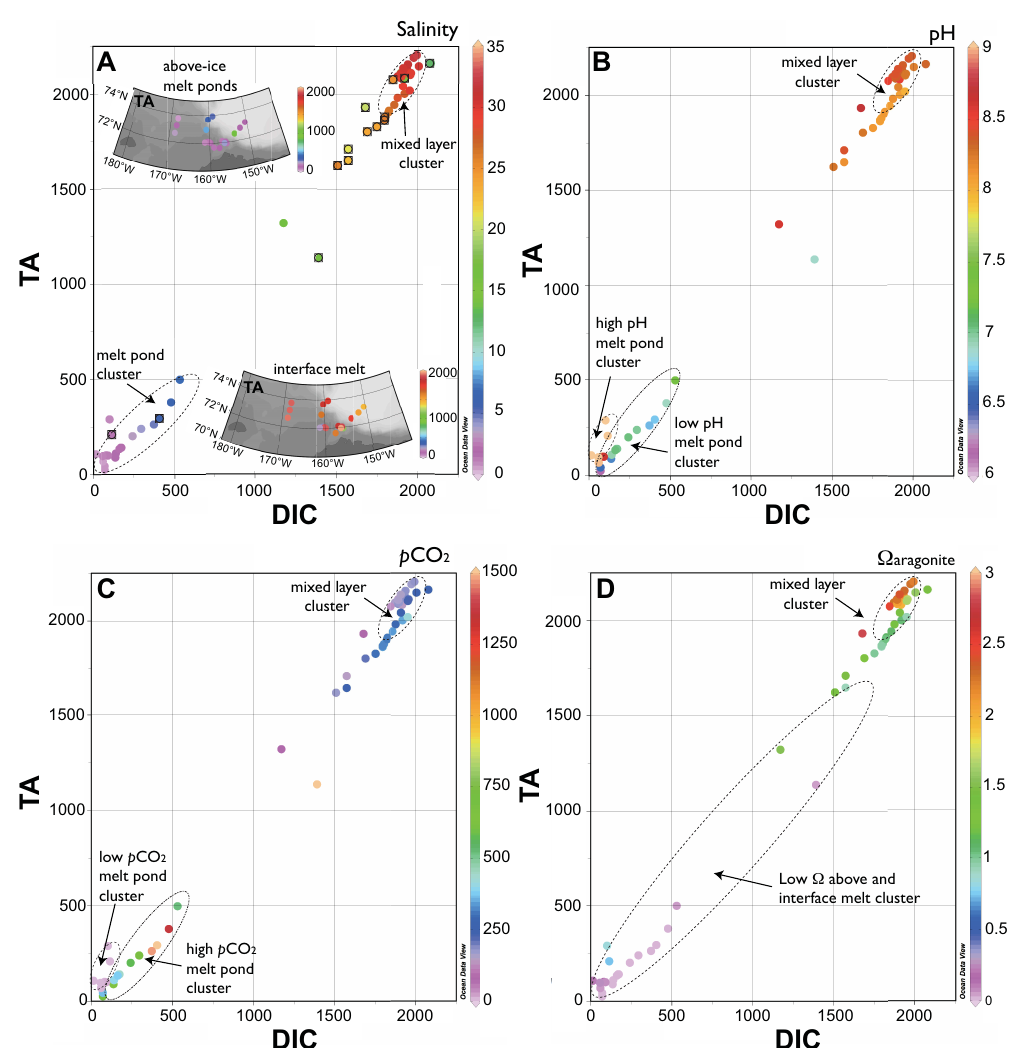
Figure 5. Scatter plots of CO 2 –carbonate chemistry for above-ice melt ponds, below-ice interface melt waters, and mixed-layer values be- neath each ice station sampled on 2010 and 2011 ICESCAPE cruises. (a) DIC (µmolkg − 1 ) versus total alkalinity (TA;µmolkg − 1 ) with range of colour denoting salinity. Surface TA is shown for above-ice melt ponds and below-ice interface melt waters in the insets. The ap- proximate chemical clustering of above-ice melt ponds, below-ice interface melt waters, and mixed-layer water is also shown. (b) DIC (µmol kg − 1 ) versus total alkalinity (TA;µmolkg − 1 ) with range of colour denoting pH. (c) DIC (µmolkg − 1 ) versus total alkalinity (TA;µmolkg − 1 ) with range of colour denoting p CO 2 . (d) DIC (µmolkg − 1 ) versus total alkalinity (TA;µmolkg − 1 ) with range of colour denoting (cid:127) aragonite